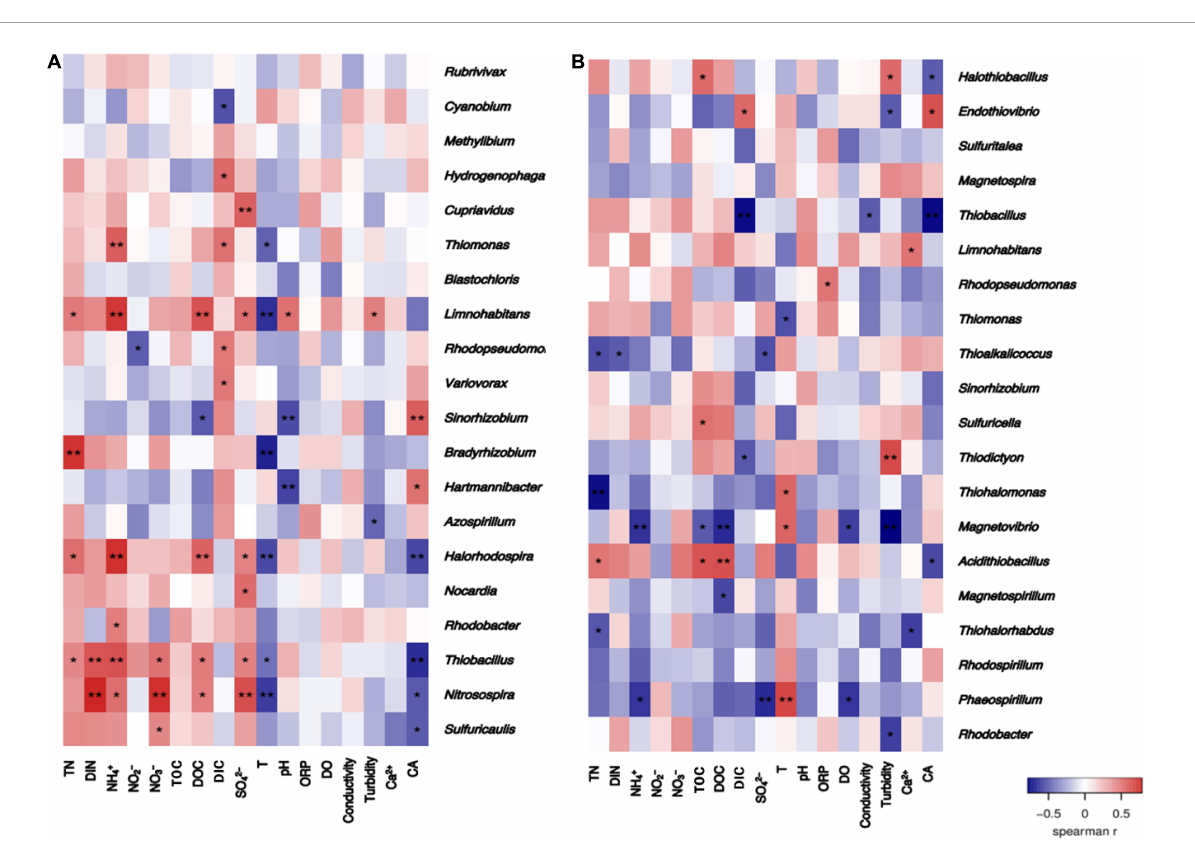
FIGURE11 Heatmaps of the Spearman correlation between the distribution of the CO 2 -fixing bacterial communities containing the cbbL (A) or cbbM (B) genes and environmental factors in the Huixian karst